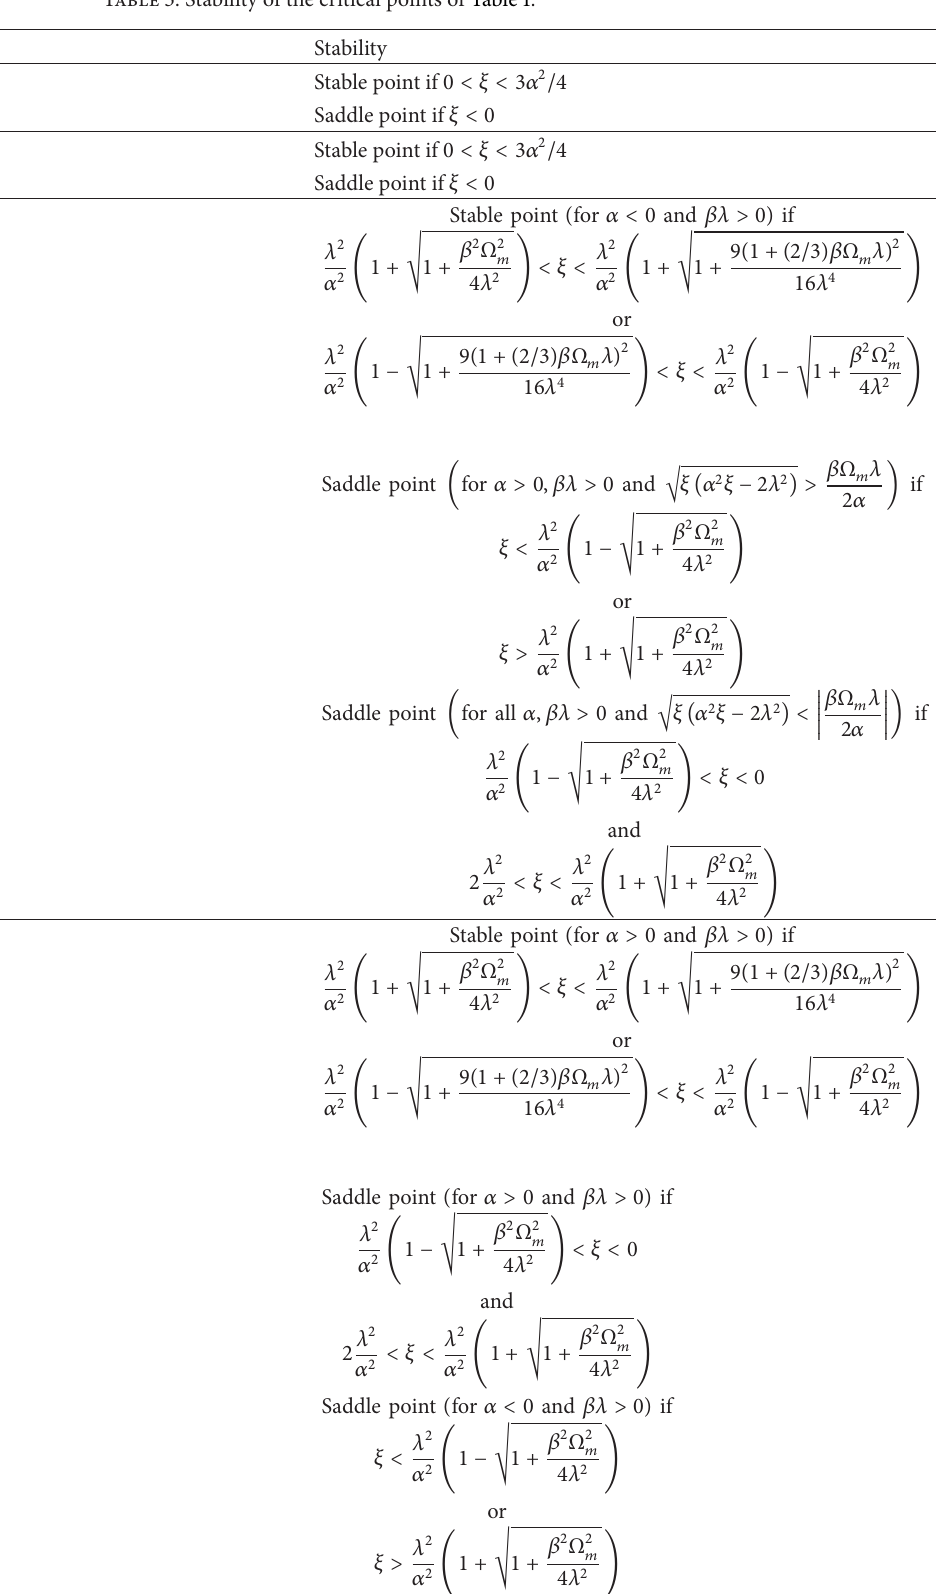
Table 3: Stability of the critical points of Table